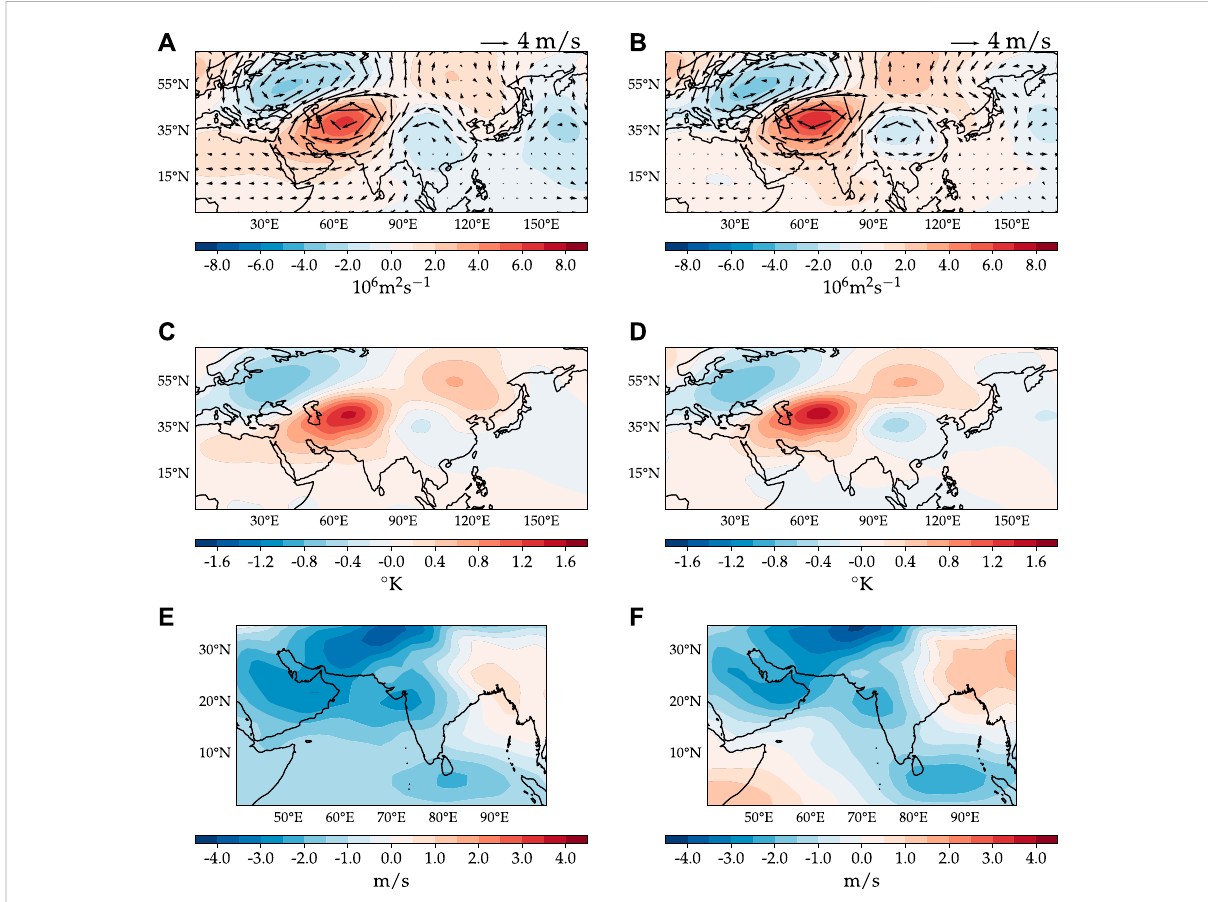
FIGURE 2 Left panel shows the difference between strong and weak WCA composites of 200 hPa eddy stream function (shaded) and wind vectors (A) , tropospherictemperature (C) andeasterlyshear (E) .Rightpanelshowsthesamedifferenceincompositesfor200 hPaeddystreamfunctionandwind vectors (B) , tropospheric temperature (D) and easterly shear (F) , but the strong (weak) WCA composites were constructed by excluding the cases when the ISM was concurrently strong